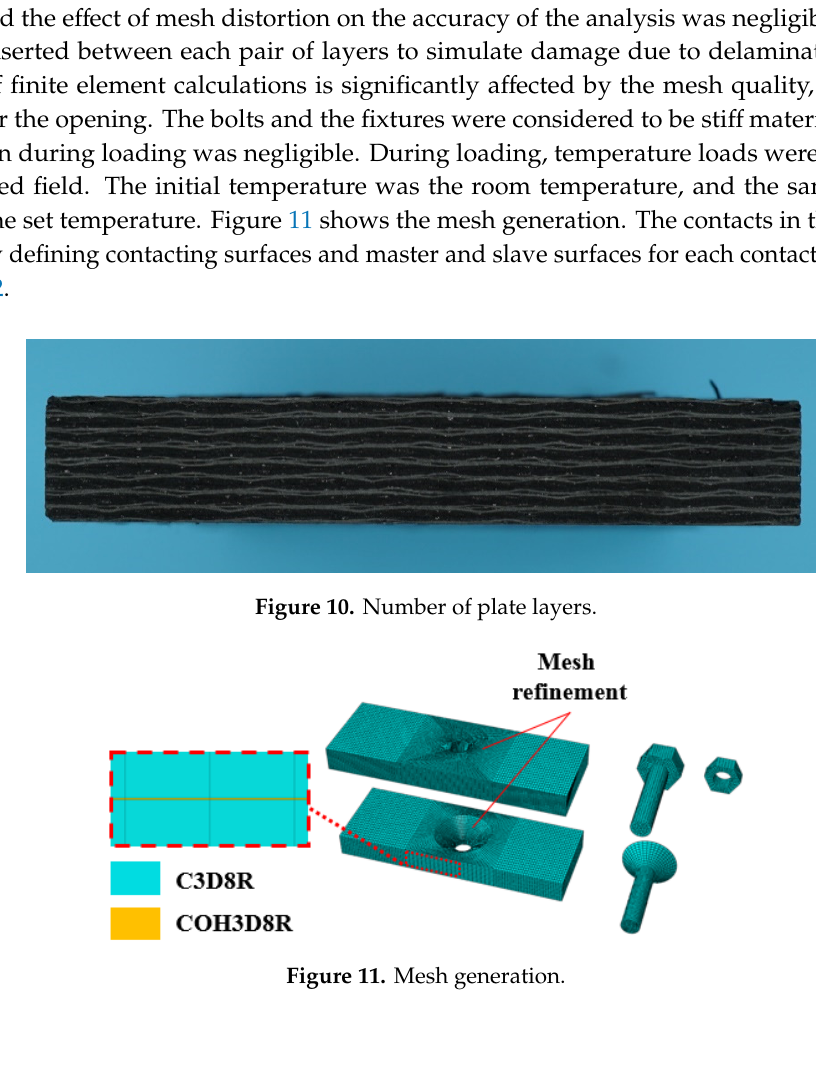
Figure 11. Mesh generation.